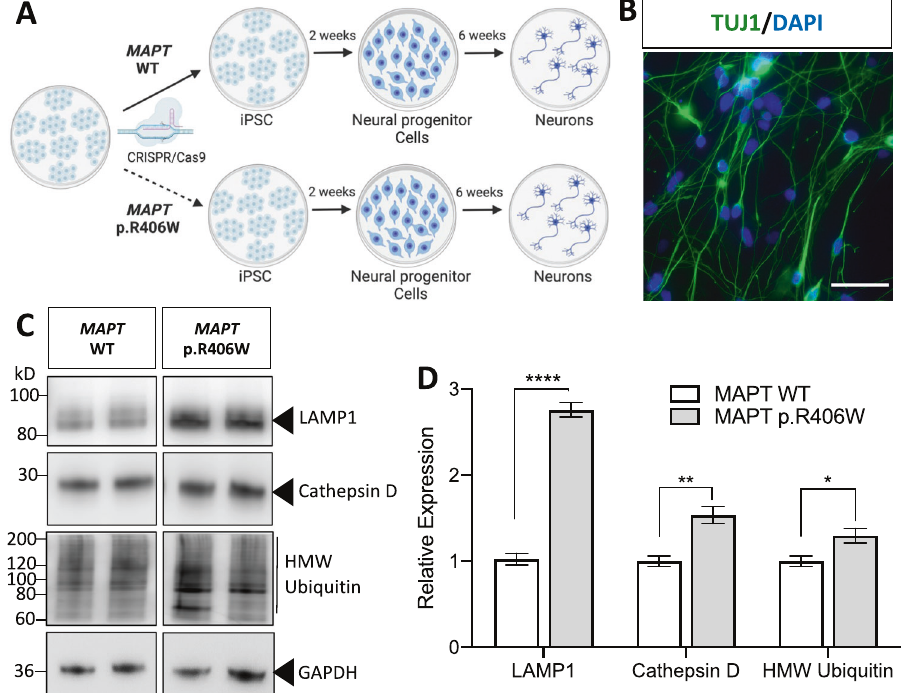
Fig. 2 Altered proteostasis in human iPSC-neurons expressing the MAPT p.R406W mutation. A iPSC from a MAPT mutation carrier and CRISPR/Cas9-corrected control (wild-type (WT)) were differentiated into cortical neurons and cultured for 6 weeks prior to analysis. B Representative immunostaining for Tuj1 (green) and DAPI (blue) illustrates that at 6 weeks in culture, cells are enriched for neurons. Scale bar, 10 microns. C Immunoblots of cell lysates (10 μ g total protein) were probed with LAMP1, Cathepsin D and ubiquitin antibodies. D Quanti fi cation of protein analyte levels in the MAPT p.R406W neurons and isogenic controls. Graph represents mean ± SEM. Signi fi cance was determined using an unpaired, t -test. * p < 0.05; ** p < 0.01. **** p <